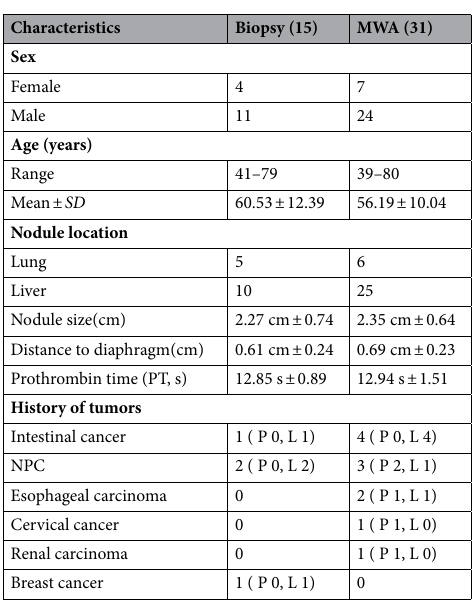
Table1. Patients baseline. SD, NPC, P, L and MWA is abbreviation of standard deviation, nasopharyngeal carcinoma, pulmonary, liver and microwave ablation